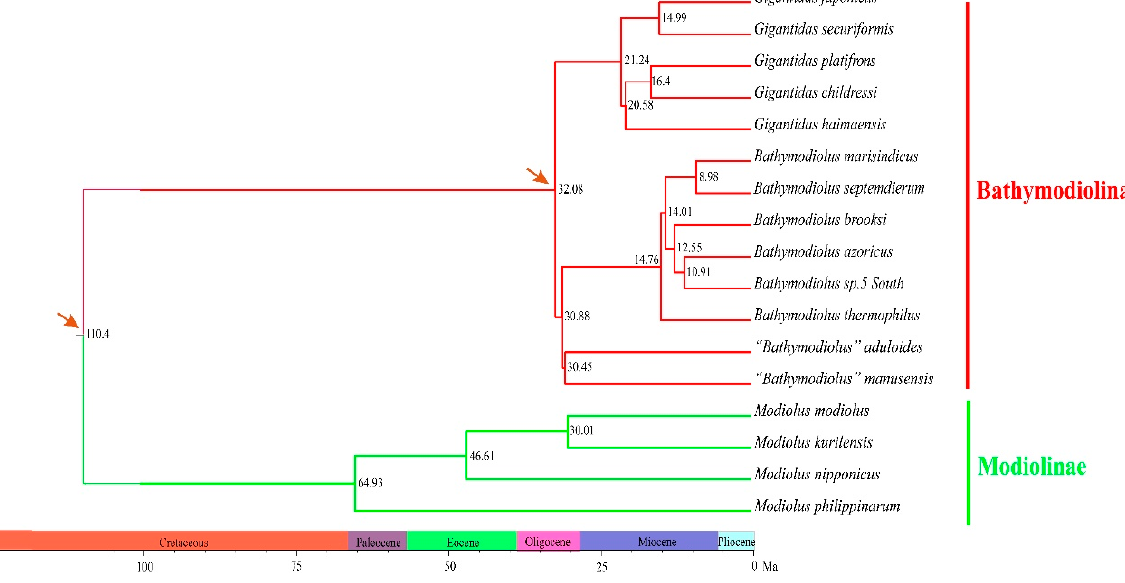
Figure 4. Molecular dating of species divergence events within the Bathymodiolinae and Modiolinae. Calibration points are marked by an arrow.